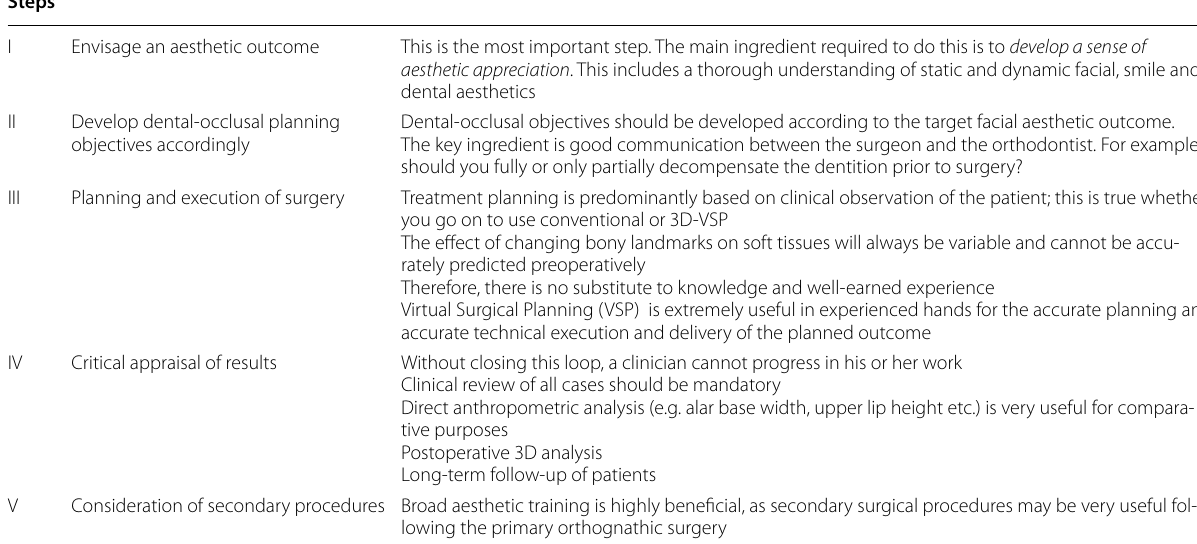
Table 1 Cardinal steps for training in aesthetic orthognathic surgical